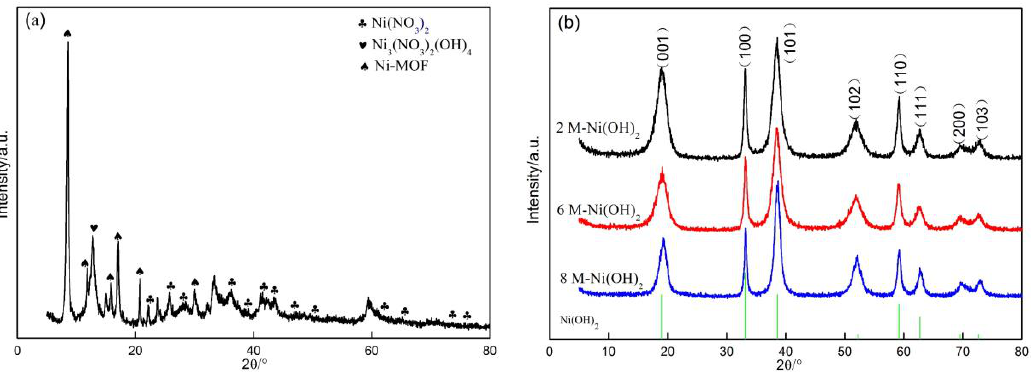
Figure 1. XRD patterns of ( a ) Ni-MOF and ( b ) Ni(OH) 2 .